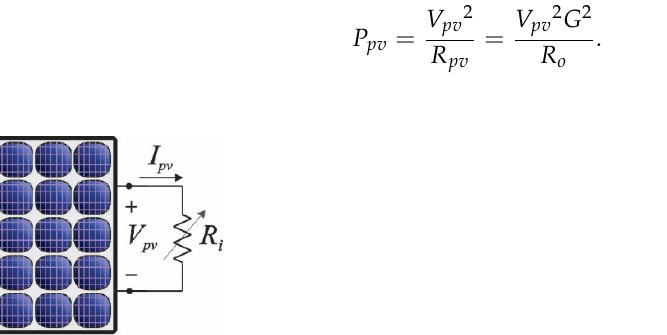
Figure 4. Simplified equivalent circuit of a DC-DC converter feeding a resistive load. Table 3. Input resistance of the main non-isolated DC-DC converters.